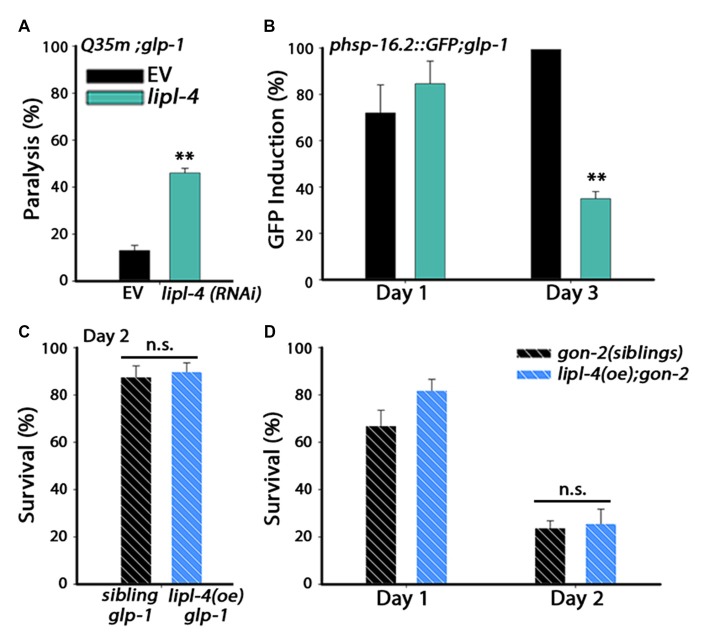
lipl-4-dependent rescue of somatic proteostasis requires the somatic gonad.
(A) Motility was scored on day 6 of adulthood. Age-synchronized glp-1 animals expressing Q35m were treated with lipl-4 or empty vector (EV) control RNAi and the percentage of paralyzed animals was determined. (B) Heat shock gene induction was examined. Age-synchronized glp-1 animals expressing phsp-16.2::GFP were treated with lipl-4 or EV control RNAi and subjected to heat shock (90 min at 37°C) on day 1 and day 3 of adulthood. The percentage of animals showing a fluorescent signal in the gut was scored. (C) Thermo-resistance was examined in age-synchronized glp-1;lipl-4(oe) animals and their siblings. Animals were subjected to heat shock (6 h at 37°C) on day 2 of adulthood and survival was assayed. (D) Thermo-resistance was examined in age-synchronized gon-2;lipl-4(oe) animals and their siblings. Animals were subjected to heat shock (6 h at 37°C) on day 1 and day 2 of adulthoods and survival was assayed. For (A,B) data was compared to EV control. For (C,D) data was compared to age-matched sibling animals examined under the same condition. (n.s.) no statistical significance, **denotes P < 0.01.